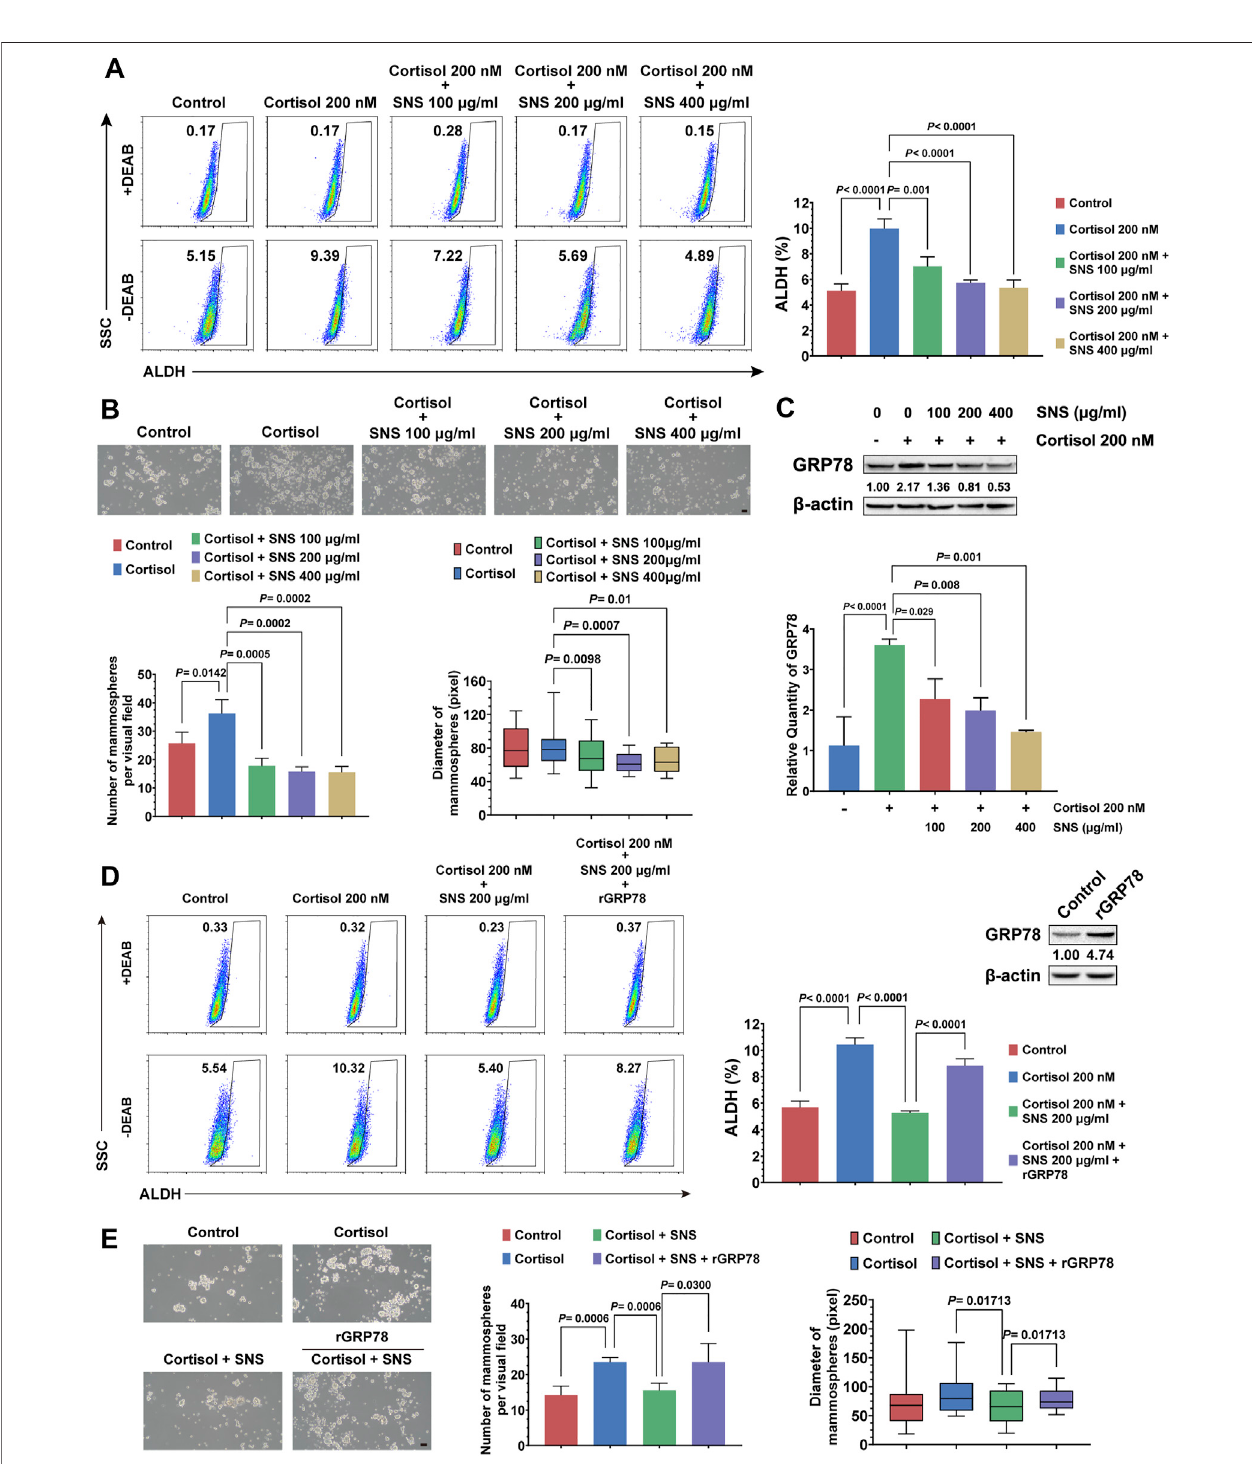
FIGURE 5 | SNS inhibits the cortisol-induced stemness of breast cancer cells by suppressing GRP78. (A) The ALDH + cell population induced by cortisol was analyzed in 4T1 cells after treatment with SNS at a gradient concentration for 24 h. (B) The size and number of mammospheres induced by cortisol were quanti fi ed followingtreatmentwithSNSfor24 h(thescalebarsindicate100 μ m). (C) FollowingSNStreatmentfor24 h,theproteinandmRNAexpressionofGRP78inthe4T1cells under cortisol treatment was measured by western blots (upper panel) and qPCR (lower panel), respectively. (D) The effect of GRP78 overexpression on the anti- CSCsactivityofSNSwasanalyzedby fl owcytometry. (E) TheeffectofGRP78overexpressionontheinhibitedactivityofSNSonthemammosphereformationabilitywas analyzed (the scale bars indicate 100 μ m). Data are represented as the mean value ± SD. One representative experiment ofthree independent experiments is displayed, and one-way ANOVA and Dunnett t -test (A, B, C) or Bonferroni ’ s test (D, E) as post hoc tests were applied.